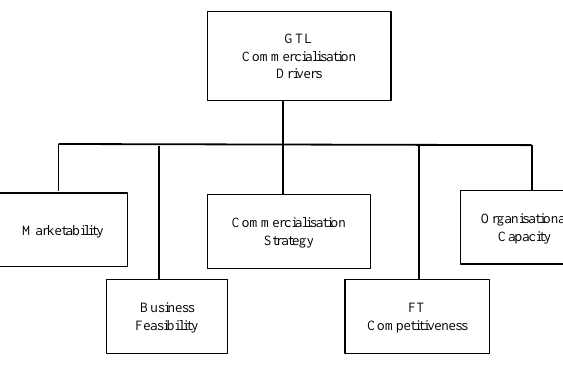
Figure 3: Relevant GTL technology commercialisation drivers (or success